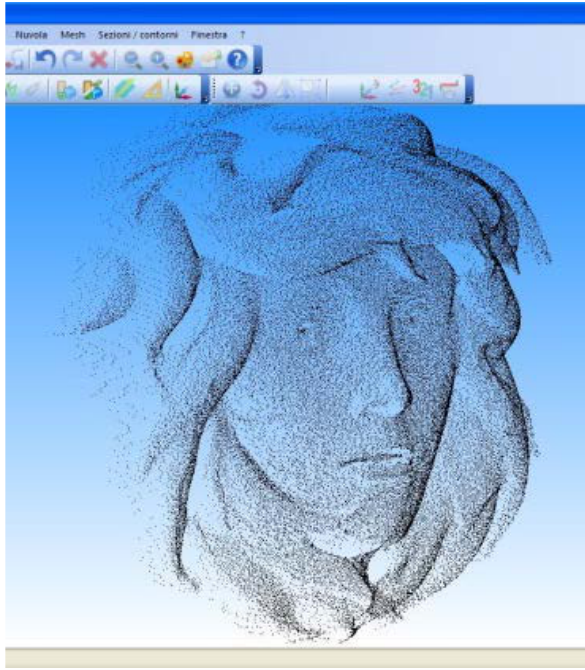
Figure 9. Point cloud of the Head of Medusa .